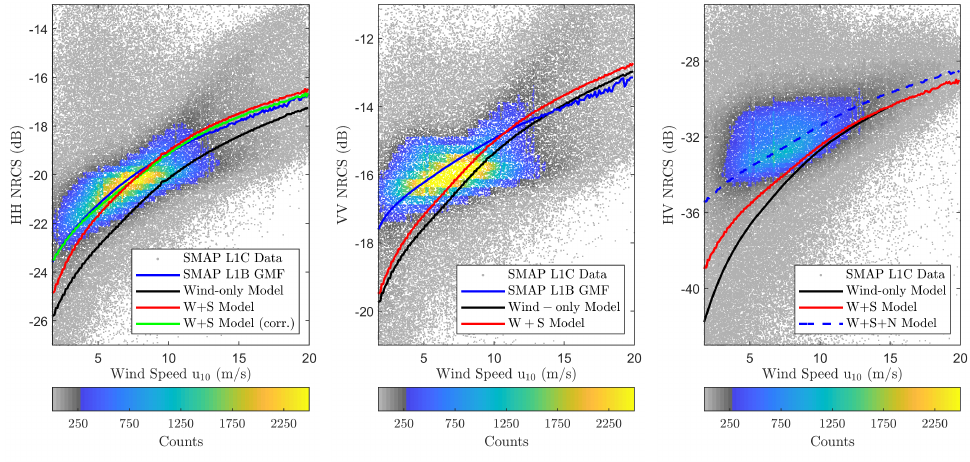
Figure 12. Combined wind and swell model (W+S) backscatter NRCS predictions vs. wind speed shown using red curves. Figures from ( left ) to ( right ) show HH- and VV-polarizations. Corrected W+S model predictions are shown using green curves. Uses the same plot configuration used in Figure